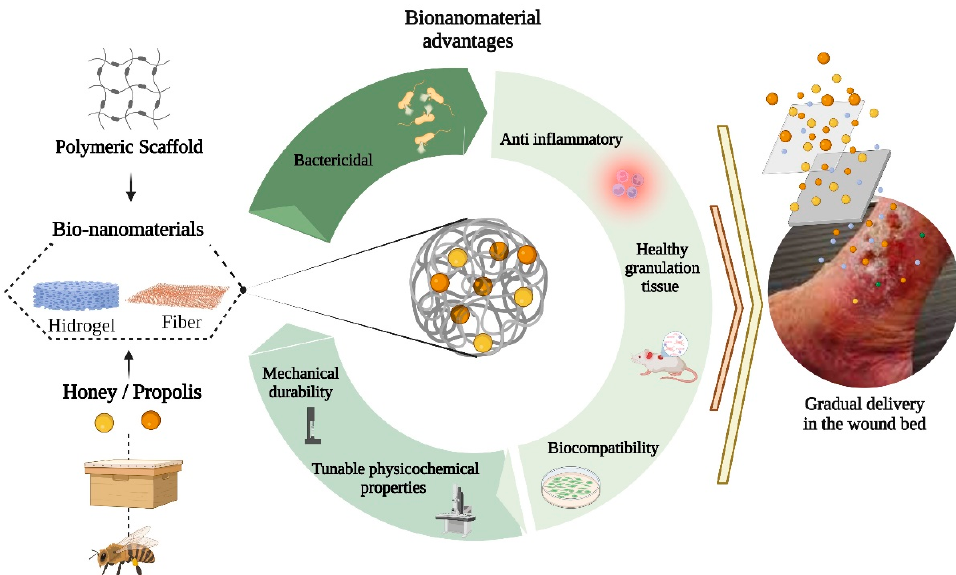
Figure 4. Advantages of bionanomaterials for wound healing. Honey and/or propolis blended with polymer scaffolds at the nanoscale improve the response rate of this therapy by modulating the wound microenvironment or by improving the penetration of multiple phytochemicals and other components of honey and propolis in the wound bed. Created with BioRender.com.